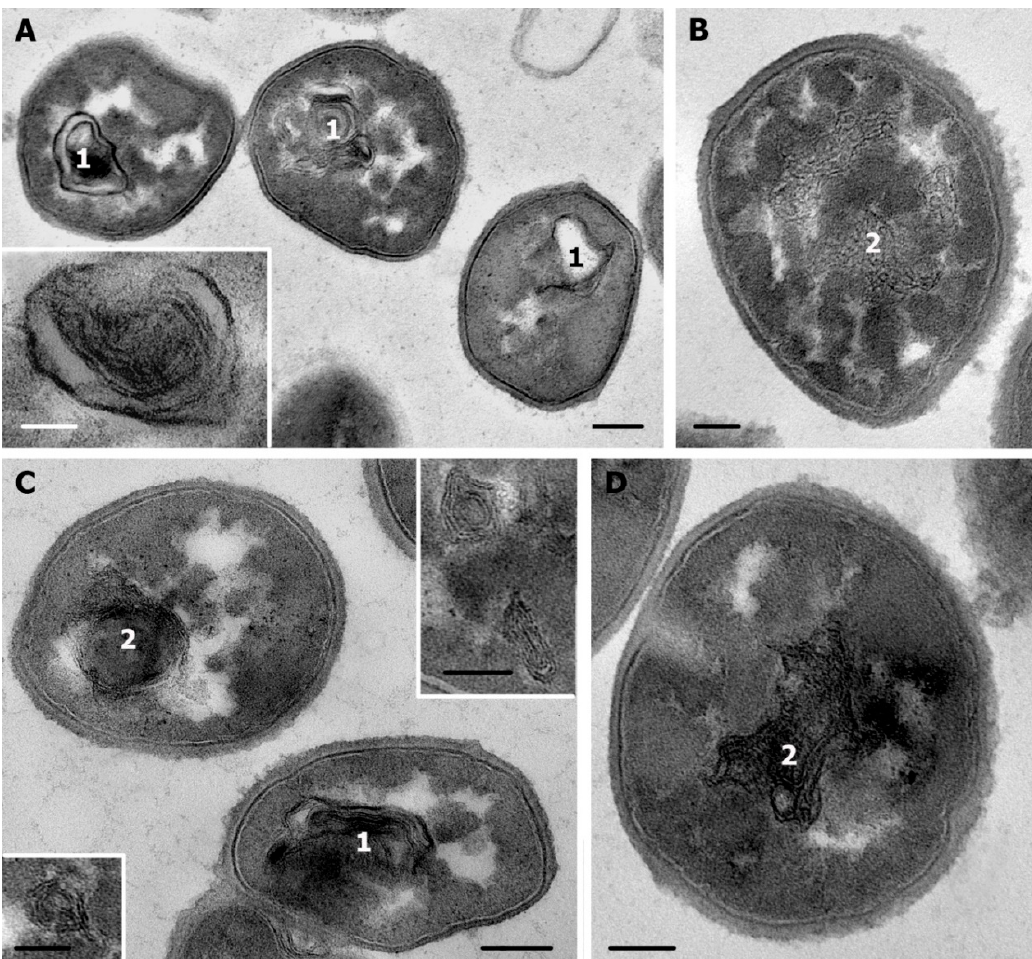
Figure 6. Cells of S. aureus incubated for 4 h with R9F2 ( A , C ) and (KFF)3K ( B , D ) peptides. 1—multimembrane structures, the insert on image A shows these structure at high magnification, 2—“decorated” fibers, inserts on image C shows “decorated” fibers at high magnification. TEM of ultrathin sections. Scale bars correspond to: ( A , C )—200 nm, ( B , D )—100 nm, insets—50